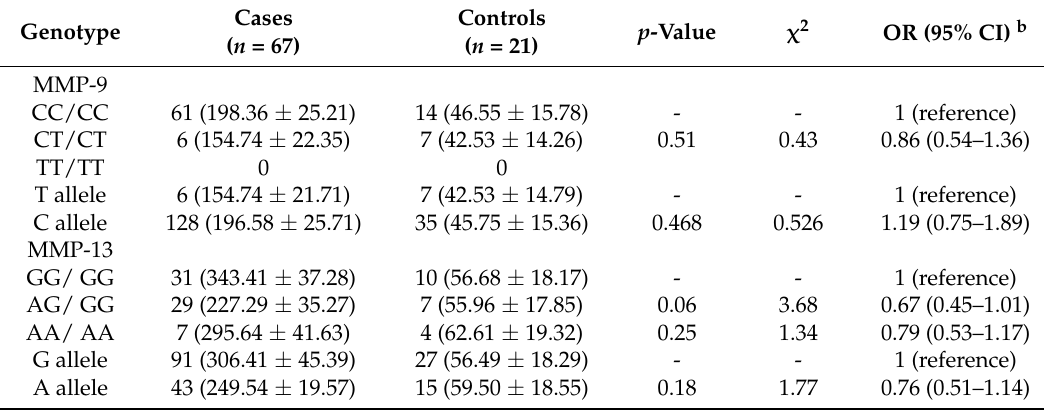
Table 9. The association with serum levels and matrix metalloproteinase (MMP) genotype in NSCLC and